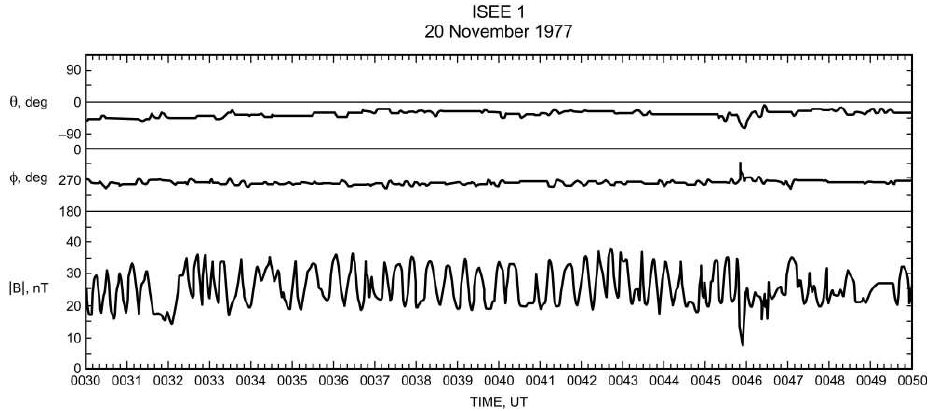
Fig. 10. Mirror mode structures in the Earth’s magnetosheath. The structures are quasiperiodic and there are little or no field directional changes across them.